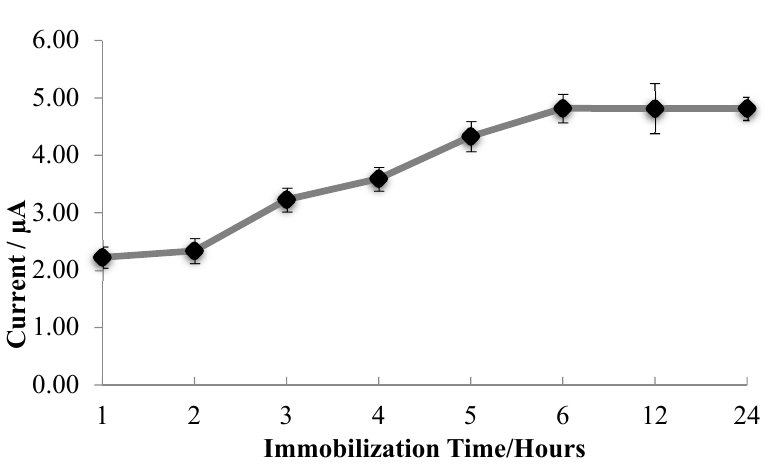
Figure 5. Influence of the laccase immobilization time on the anodic peak currents of 0.5 μ M Tartrazine. Error bar represents the standard deviation of triple measurements.